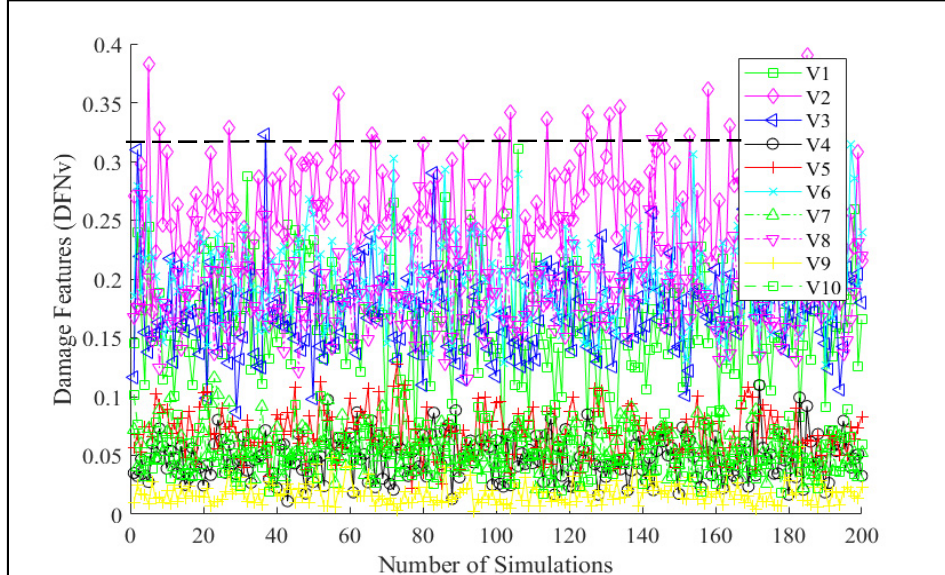
Figure 6. DFN v obtained from the baseline bridge considering measurement noise and operational variation.